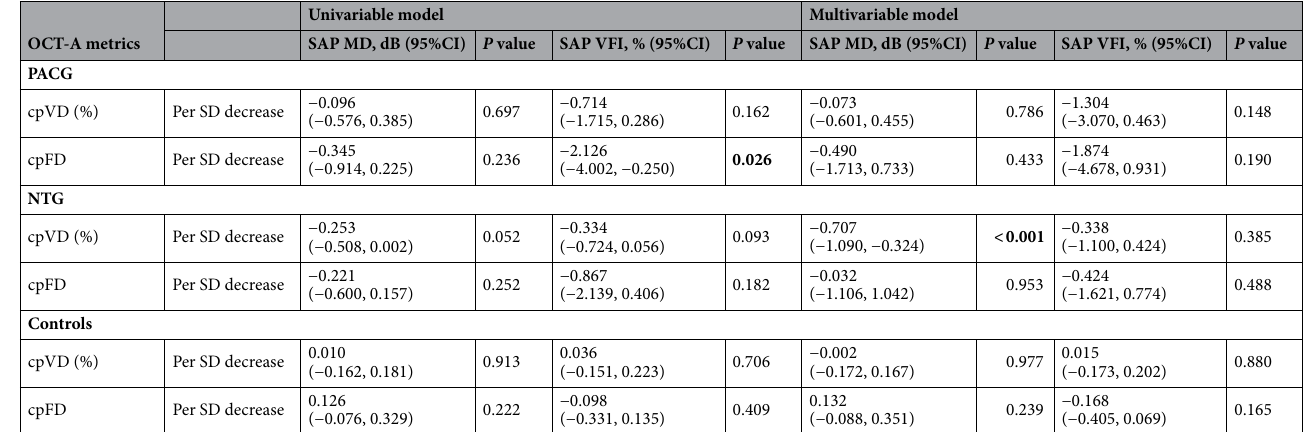
Table 4. Relationship of OCT-A metrics with visual field mean deviation and visual field index in PACG and NTG. Significant values are in bold. cpVD = circumpapillary vessel density; cpFD = circumpapillary fractal dimension; PACG = primary angle closure glaucoma; NTG = normal tension glaucoma; SAP = standard automated perimetry; MD = mean deviation; PSD = pattern standard deviation; VFI = visual field index; CI = confidence interval; SD = standard deviation. Multivariable model adjusted for age, sex, spherical equivalent, intraocular pressure, number of glaucoma medications and OCT-A image quality score.